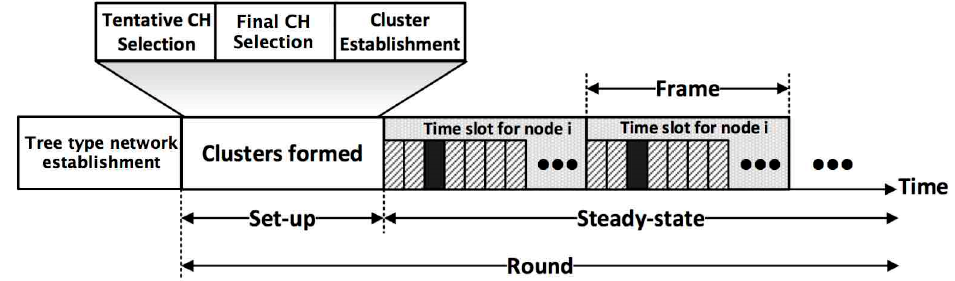
Figure 2. Timeline showing the operations of FTUC: at the first iteration, it builds a tree type sub-network. Then, periodically, it forms the clusters, and progresses to the steady state, where sensing and data transmissions are performed.